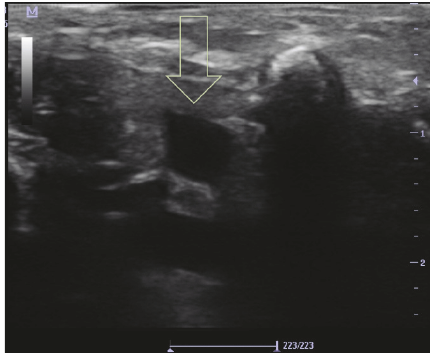
Figure 2: The ultrasound image of the subclavian vein. Yellow arrow is showing the subclavian